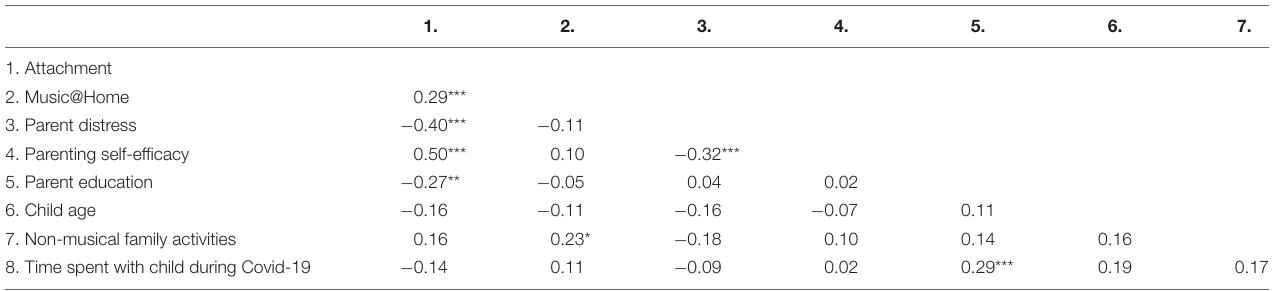
TABLE 5 | Correlations between parent-child attachment, parent-child musical engagement, and other